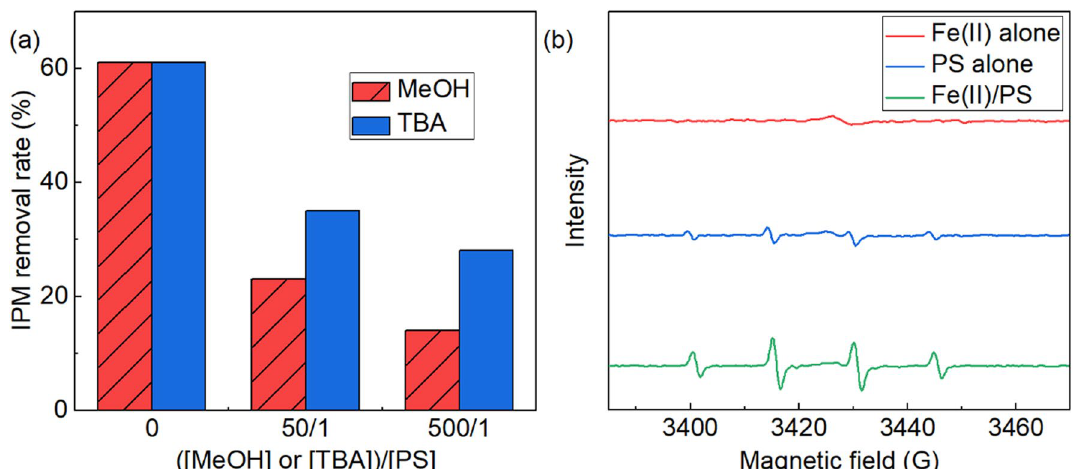
Figure 4. ( a ) IPM degradation efficiency with different inhibitors, and ( b ) EPR spectra of DMPO-OH· and DMPO-SO